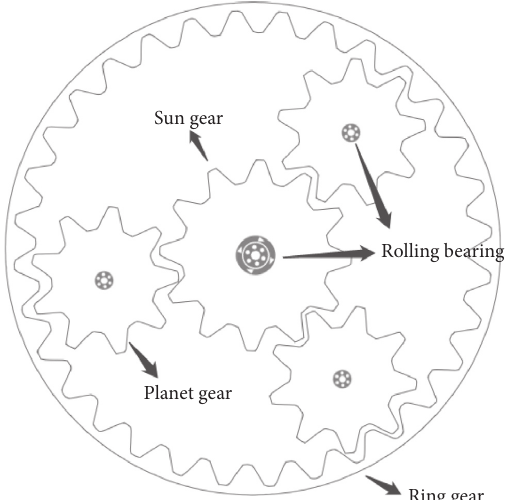
Figure 1: Schematic diagram of the planetary